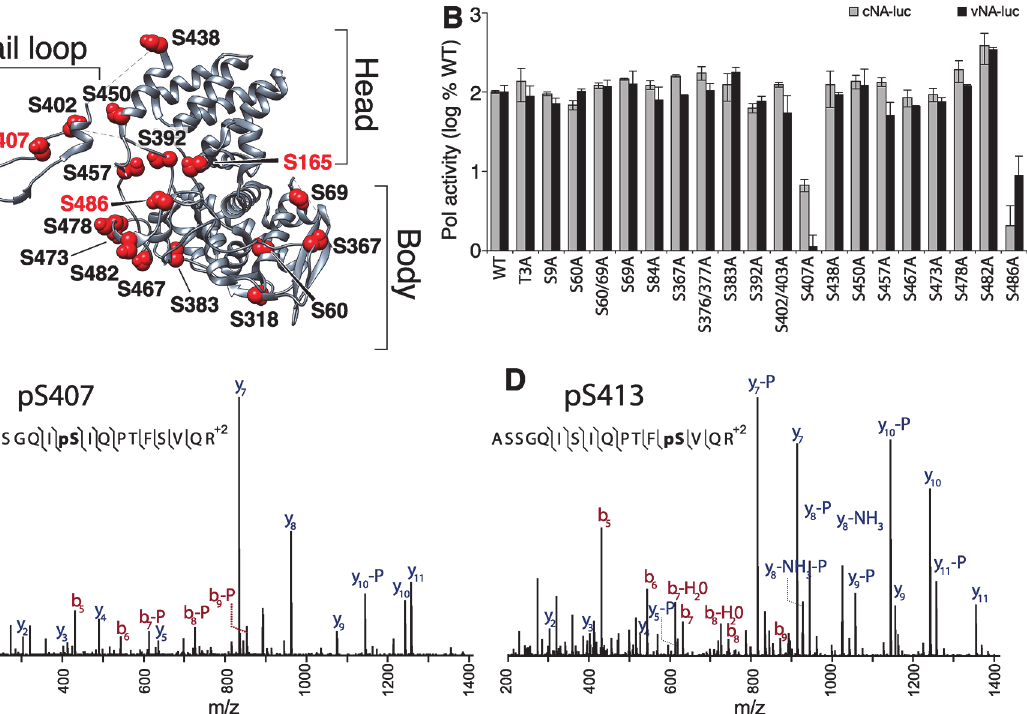
Fig 2. Identification of serine residues and a phosphorylation site in NP that are critical for polymerase activity. (A) The structure of NP (PDB 2IQH) reveals the core head and body regions as well as a tail loop that directs oligomerization. Conserved, solvent-exposed serine residues were identified in the NP protomer and selected for mutagenesis. (B) High-throughput polymerase activity assays were performed in human 293T cells expressing the viral polymerase, WT or mutant NP, and reporter constructs representing negative- (vNA-Luc) or positive-sense (cNA-Luc) RNA templates. (C, and D) Purified